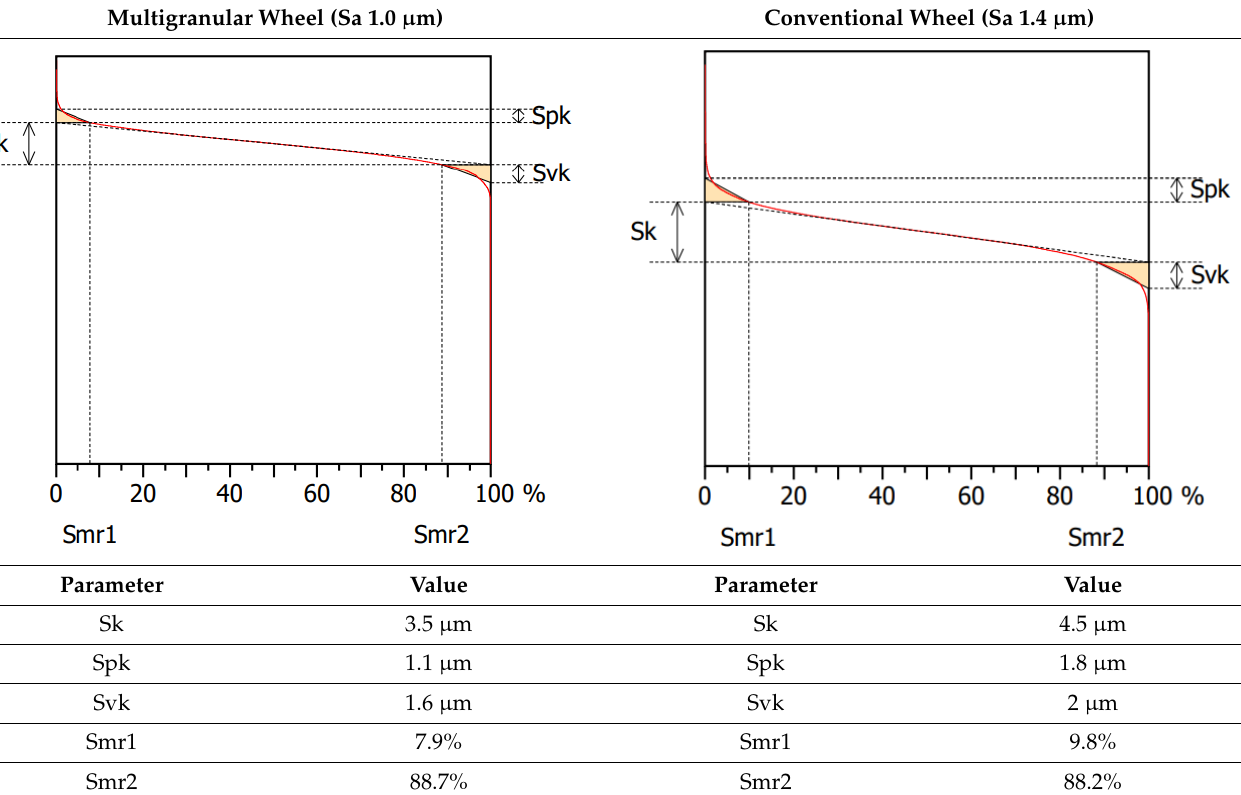
Table 4. Abbott–Firestone curves ( Vw = 11,000 mm/min, Vp = 90 mm/min and Vc = 23 m/s). Multigranular Wheel (Sa 1.0 µ m)